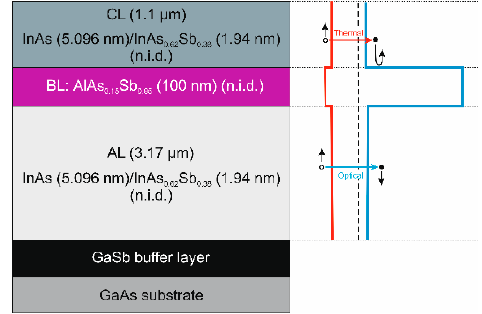
Figure 1. Architecture and schematic band diagram of the nBn T2SL